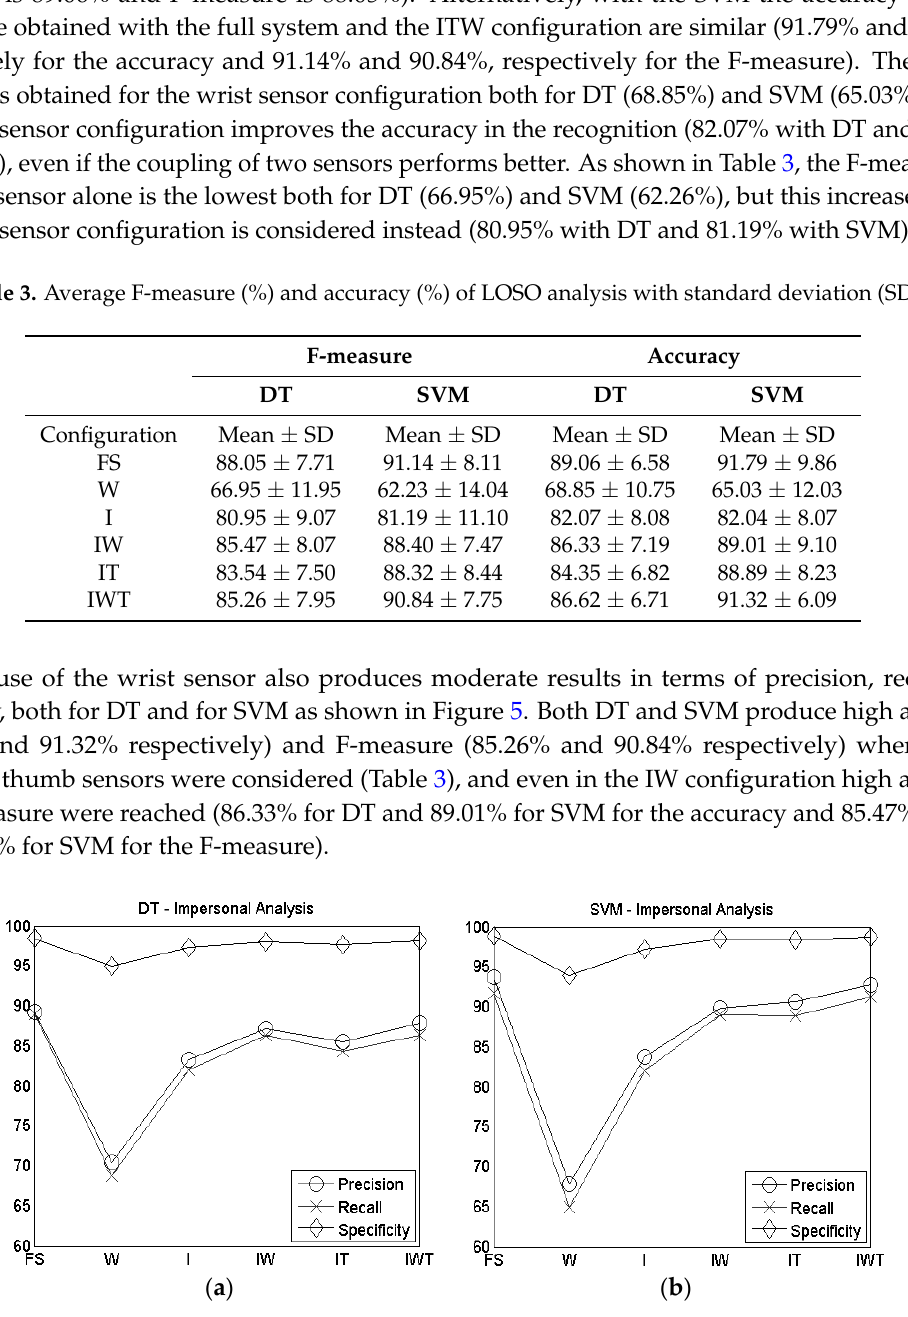
Figure 5. Precision, recall and specificity of impersonal analysis for ( a ) DT and ( b ) SVM.